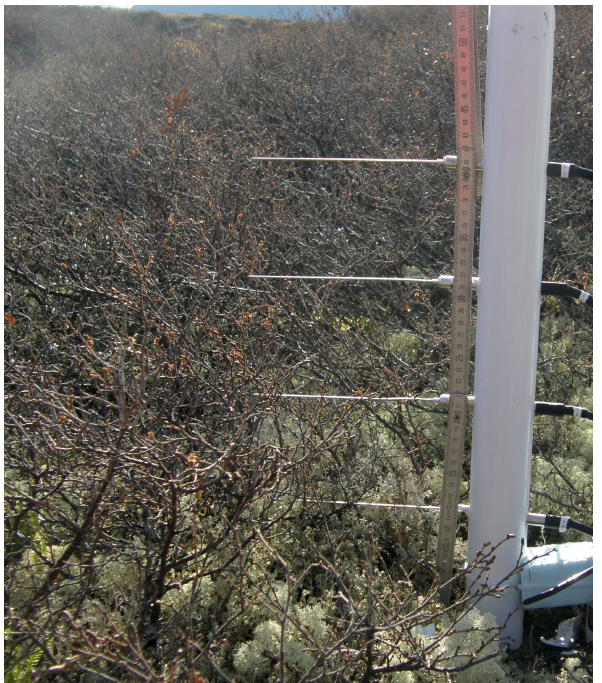
Figure 1. Photograph of the four TP02 needle probes deployed in shrub tundra. The photo was taken on 6 October 2014, when the dwarf birch had grown to about 30cm high. The needle probes are 14, 24, 34 and 44cm above the ground–lichen